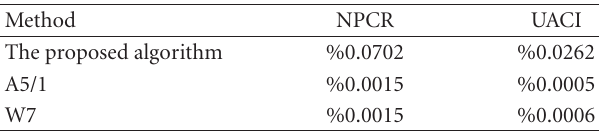
Table 5: Compare UACI and NPCR between encryption algorithms in Lena standard image.